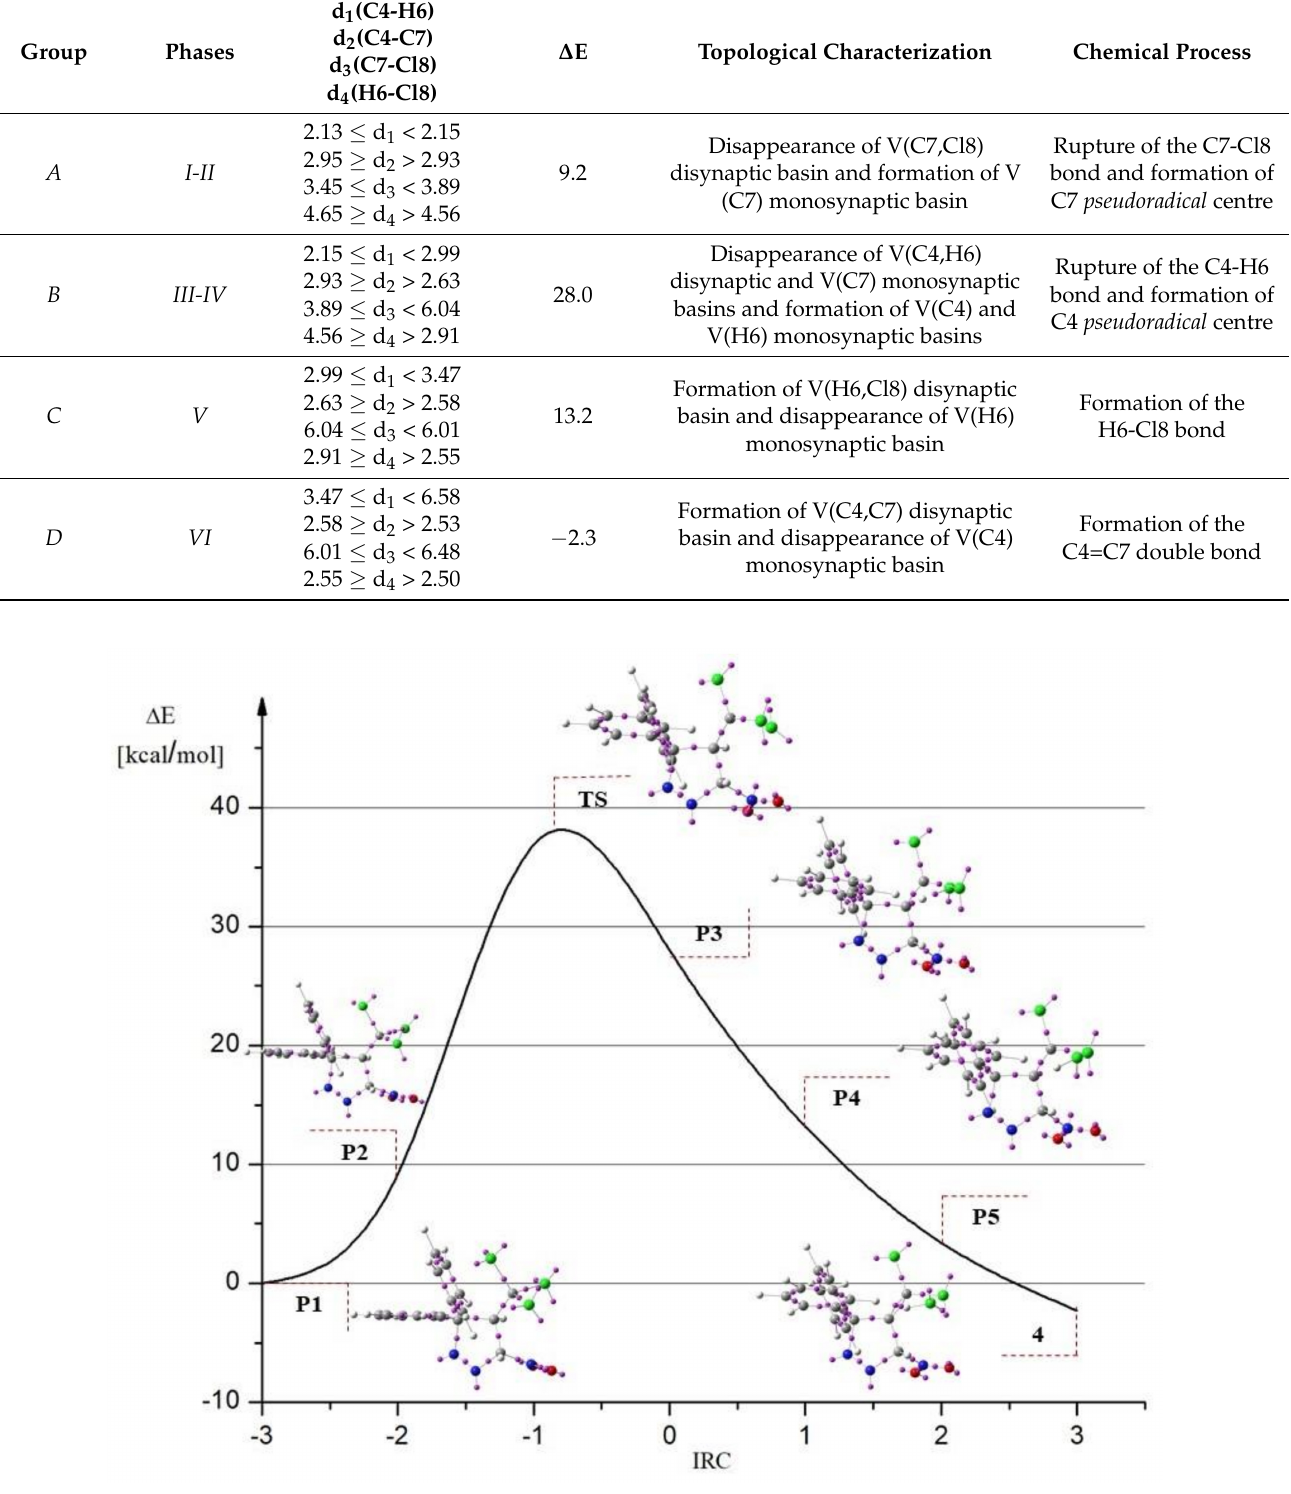
Table 2. Sequential bonding changes along the reaction of dehydrochlorination of 3 leading to formation of 4 , showing the equivalence between the topological characterisation of the different phases and the chemical processes occurring along them. Distances are given in angstroms, Å and relative energies referred to the first point on IRC path ( P1 ) are given in kcal/mol.